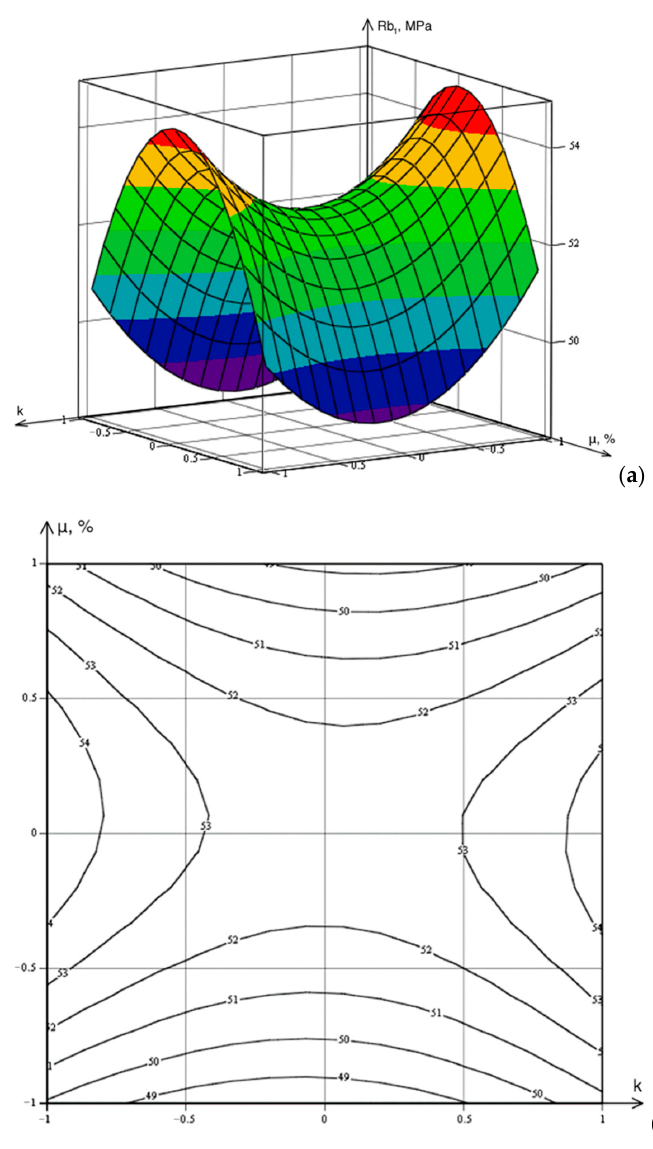
Figure 12. Dependence of the compressive strength of concrete reinforced with a combination of steel and basalt fiber ( a ) —three-dimensional surface; ( b )—isolines. Based on the results of experimental studies of the effect of a combination of various types of fibers and volume content on the strength and deformation characteristics of fiber- reinforced concrete, the optimal volume concentrations were determined for each type of fiber combination. When using a combination of steel–basalt fiber, the best strength and deformation characteristics were recorded with the volume content of steel fiber 2% and basalt 2%. When using a combination of steel–polypropylene fiber, the best strength and deformation characteristics were recorded with the volume content of steel fiber 2.5% and polypropylene 1.5%. In the combination of polypropylene–basalt fiber, the best strength and deformation characteristics were recorded with the volume content of polypropylene fiber 1.5% and basalt fiber